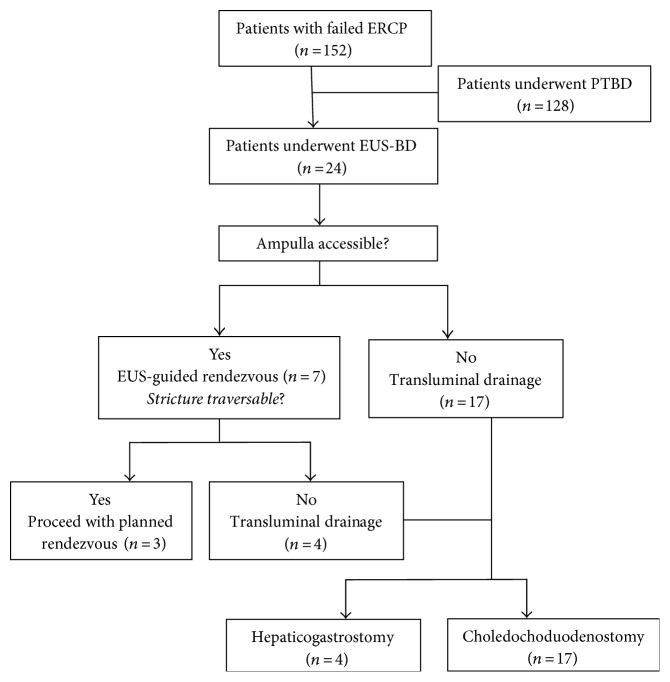
The patient flow diagram.